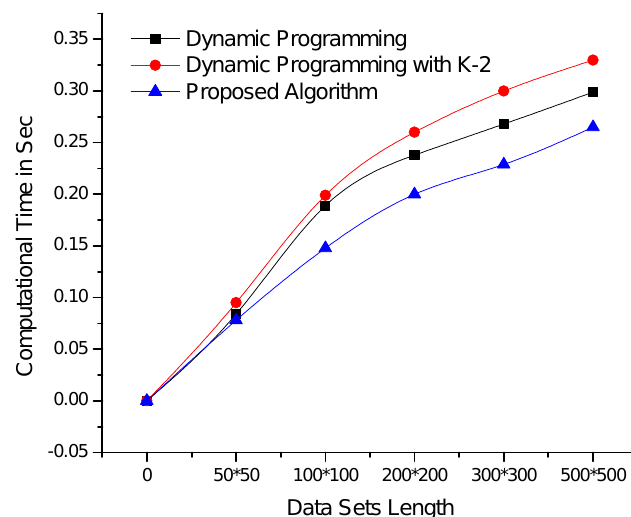
Figure 3. Comparison of the computational times of the proposed and dynamic programming-based algorithms—using data sets of constant length and variable dimensionality (the lowest lines i.e., minimum values are better).